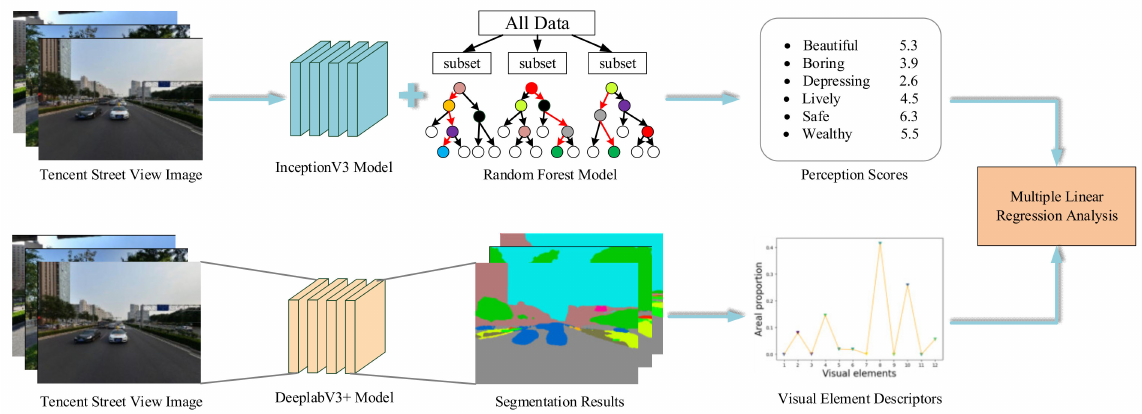
Figure 4. Multiple linear regression analysis between the perceptual scores and the visual